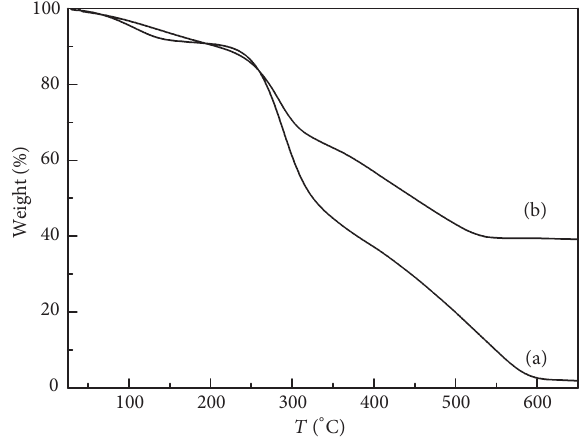
F 6: FTIR spectra of the pure CS (a) and the magnetic composite (b) microcapsules.